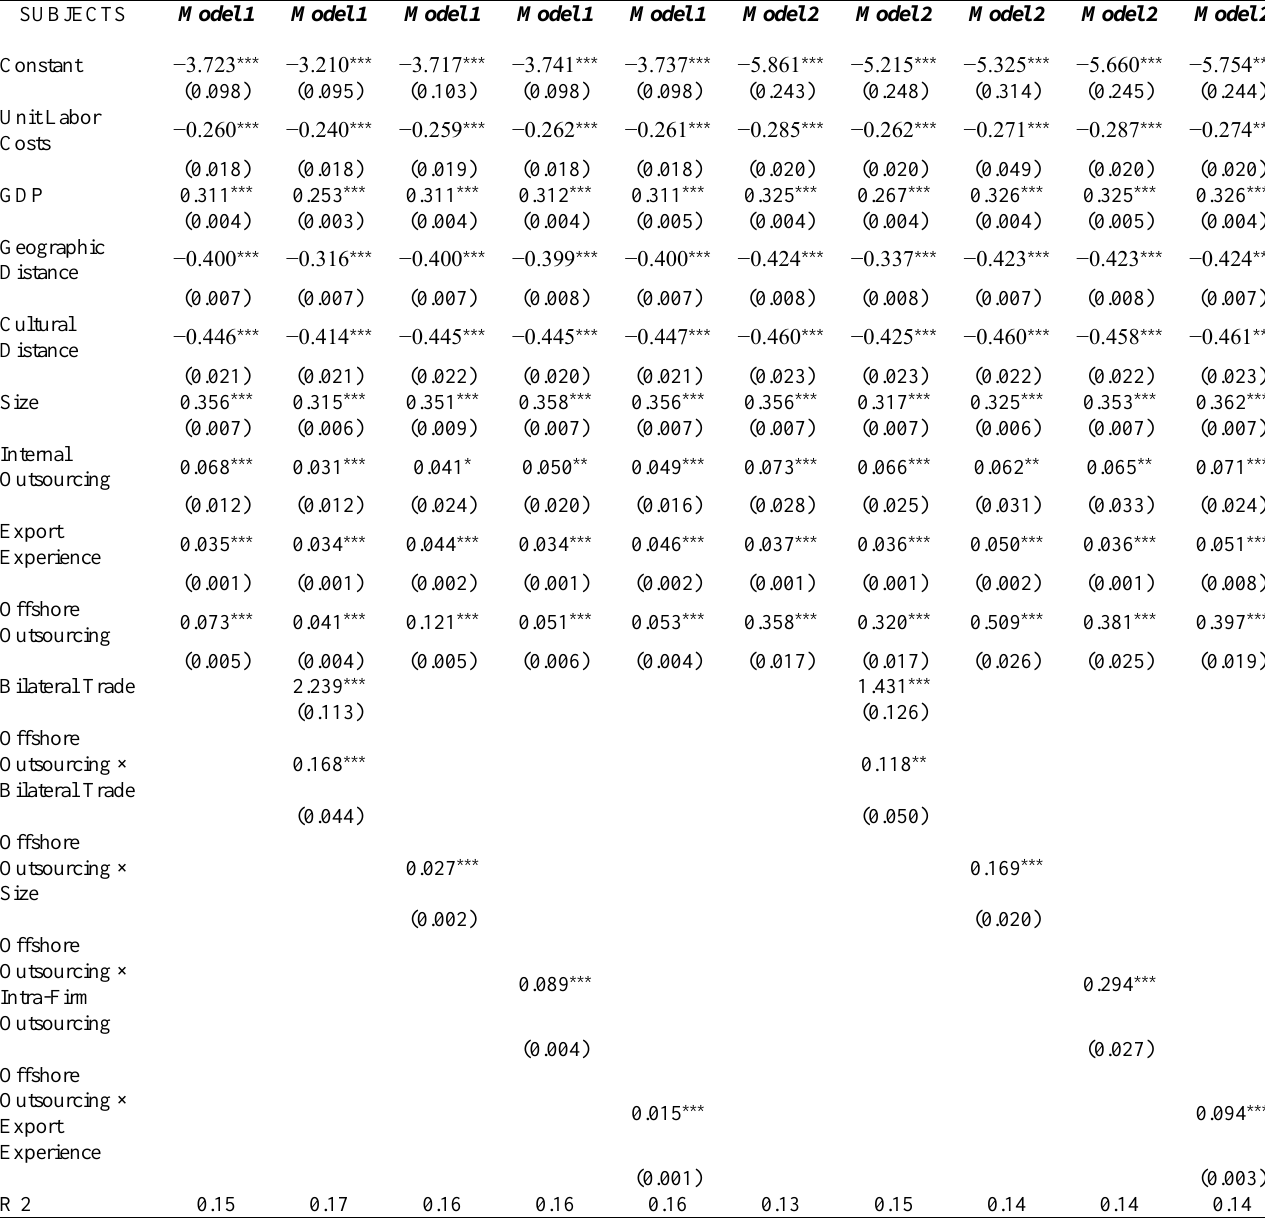
Table 1. Results of the